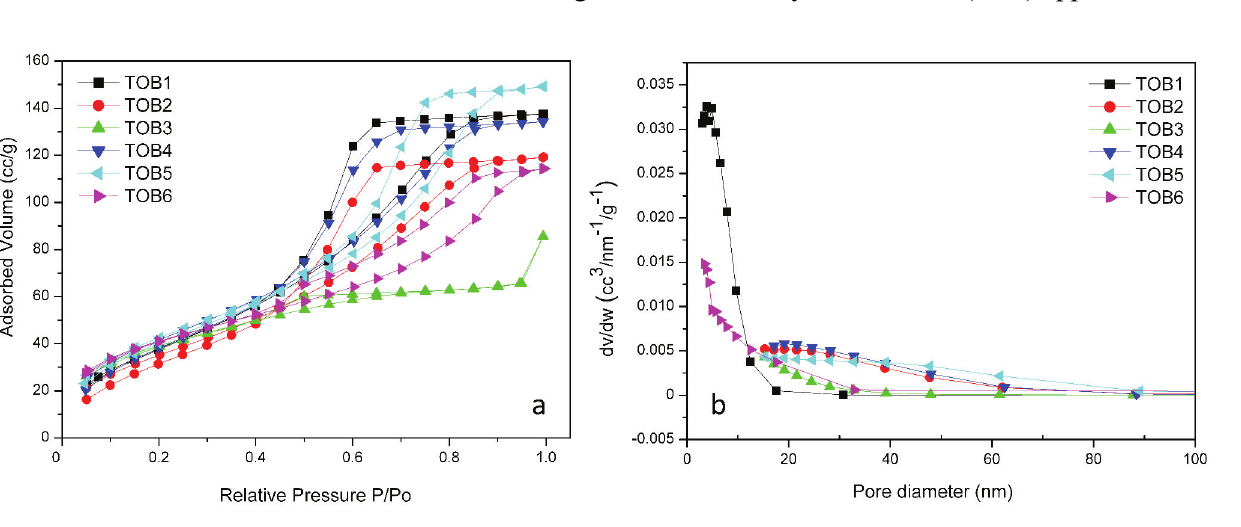
Figure 5. ( a ) Nitrogen adsorption-desorption isotherms of the TiO